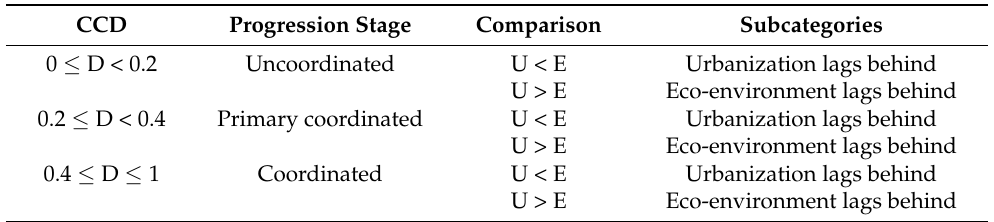
Table 2. Classification standard of the CCD between the EEQ and urbanization based on the classifi- cation